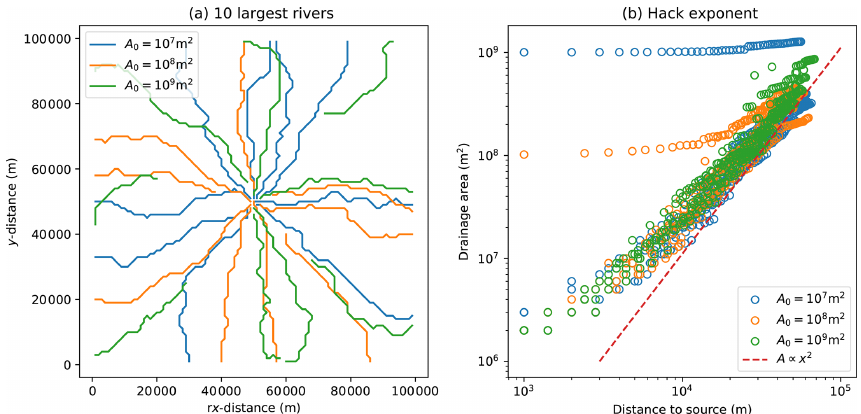
Figure 17. Results of three two-dimensional landscape evolution models where sediment and water are provided at a rate proportional to the surface area, A 0 , of an assumed upstream catchment at the center of the model leading to the formation of a conic sedimentary system. The three models correspond to three different values of A 0 . (a) Geometry of the 10 major rivers for each of the three models and (b) computed relationship between drainage area and distance to source for those 10 major rivers; the dashed red line has a slope corresponding to an exponent of p = 2 in Hack’s law.